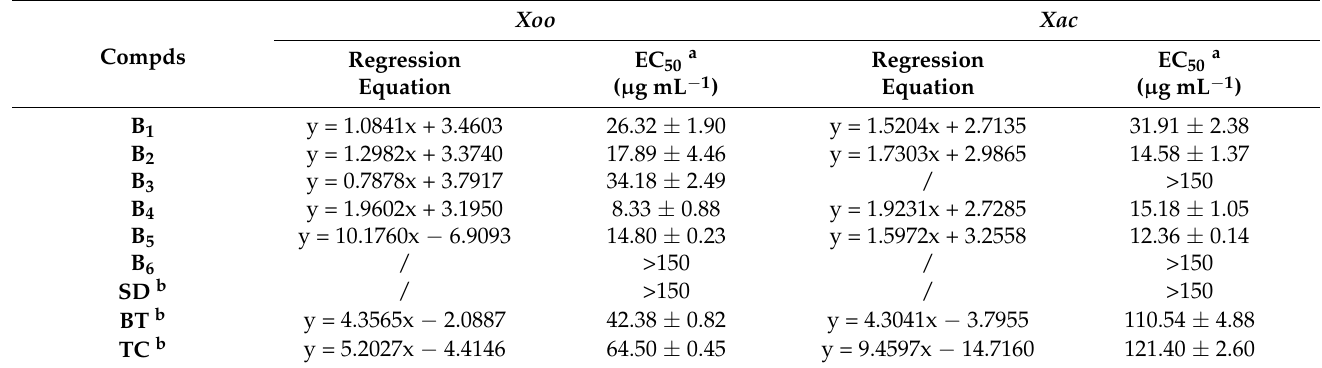
1 − B 6 against plant pathogens.